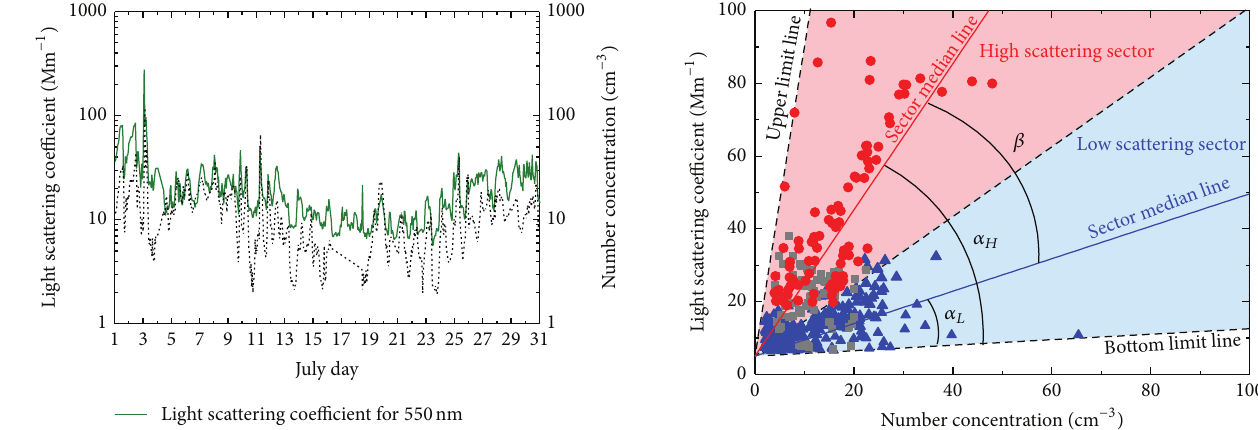
number concentration were observed on 1st (33 cm −3 ), 2nd (43 cm −3 ), 3rd (118 cm −3 ), 11th (65 cm −3 ), 19th (24 cm −3 ), and 25th (39 cm −3 ) of July. Therefore, below we focused our study on relationship between the particle number concentration and the light scattering coefficient (Figure 2). Statistical analysis of data showed a positive correlation ( 𝑅 2 = 0.82 )